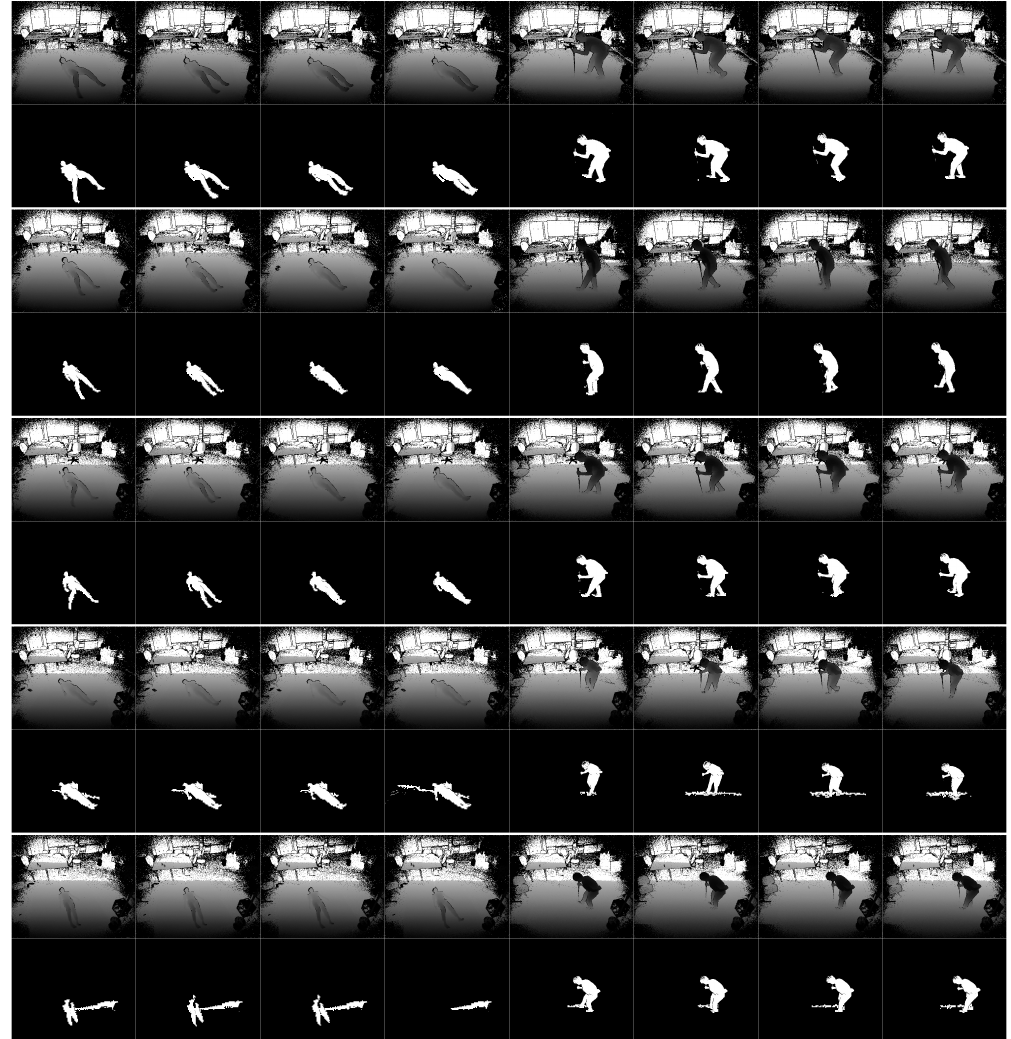
Figure 3. Human segmentation using Kinect SDK. Five lines are human segmentation results from Kinect set at 1.7, 1.9, 2.1, 2.3 and 2.5